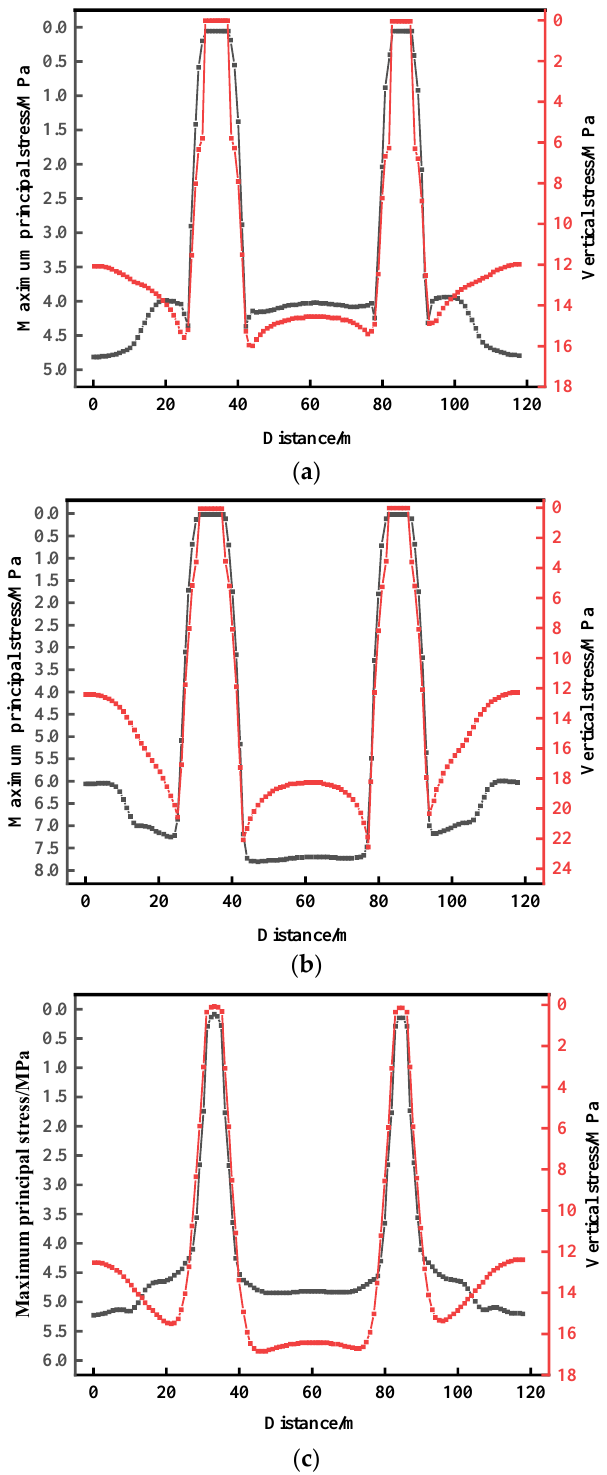
Figure 9. Stress variation characteristics of different section heights in the cavern group. ( a ) The roof position of the cavern; ( b ) the middle position of the cavern; and ( c ) the bottom position of the cavern.